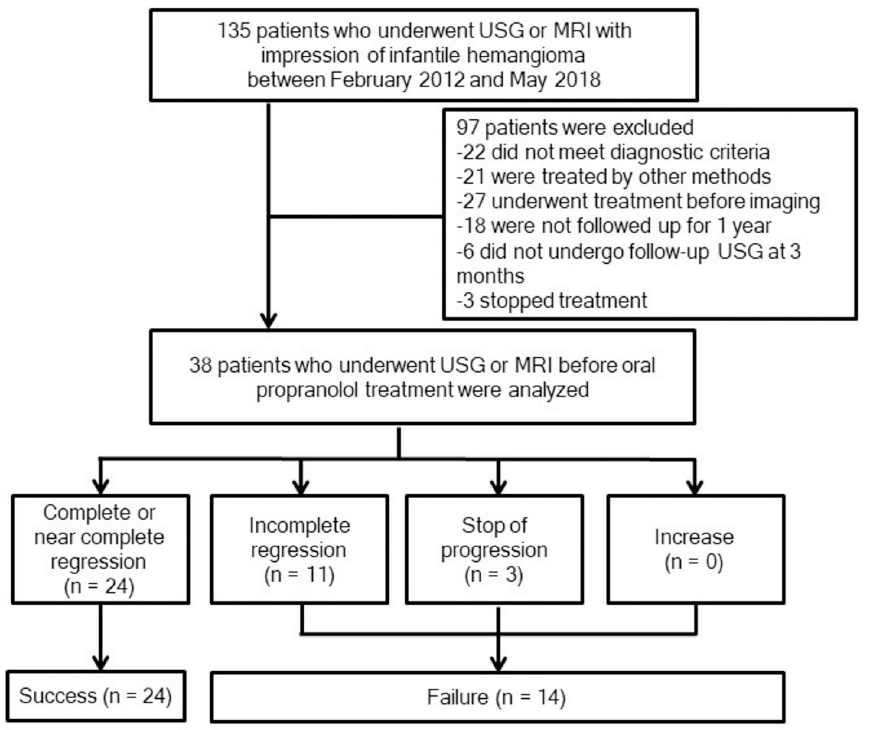
Fig 1. Flow diagram for inclusion of study